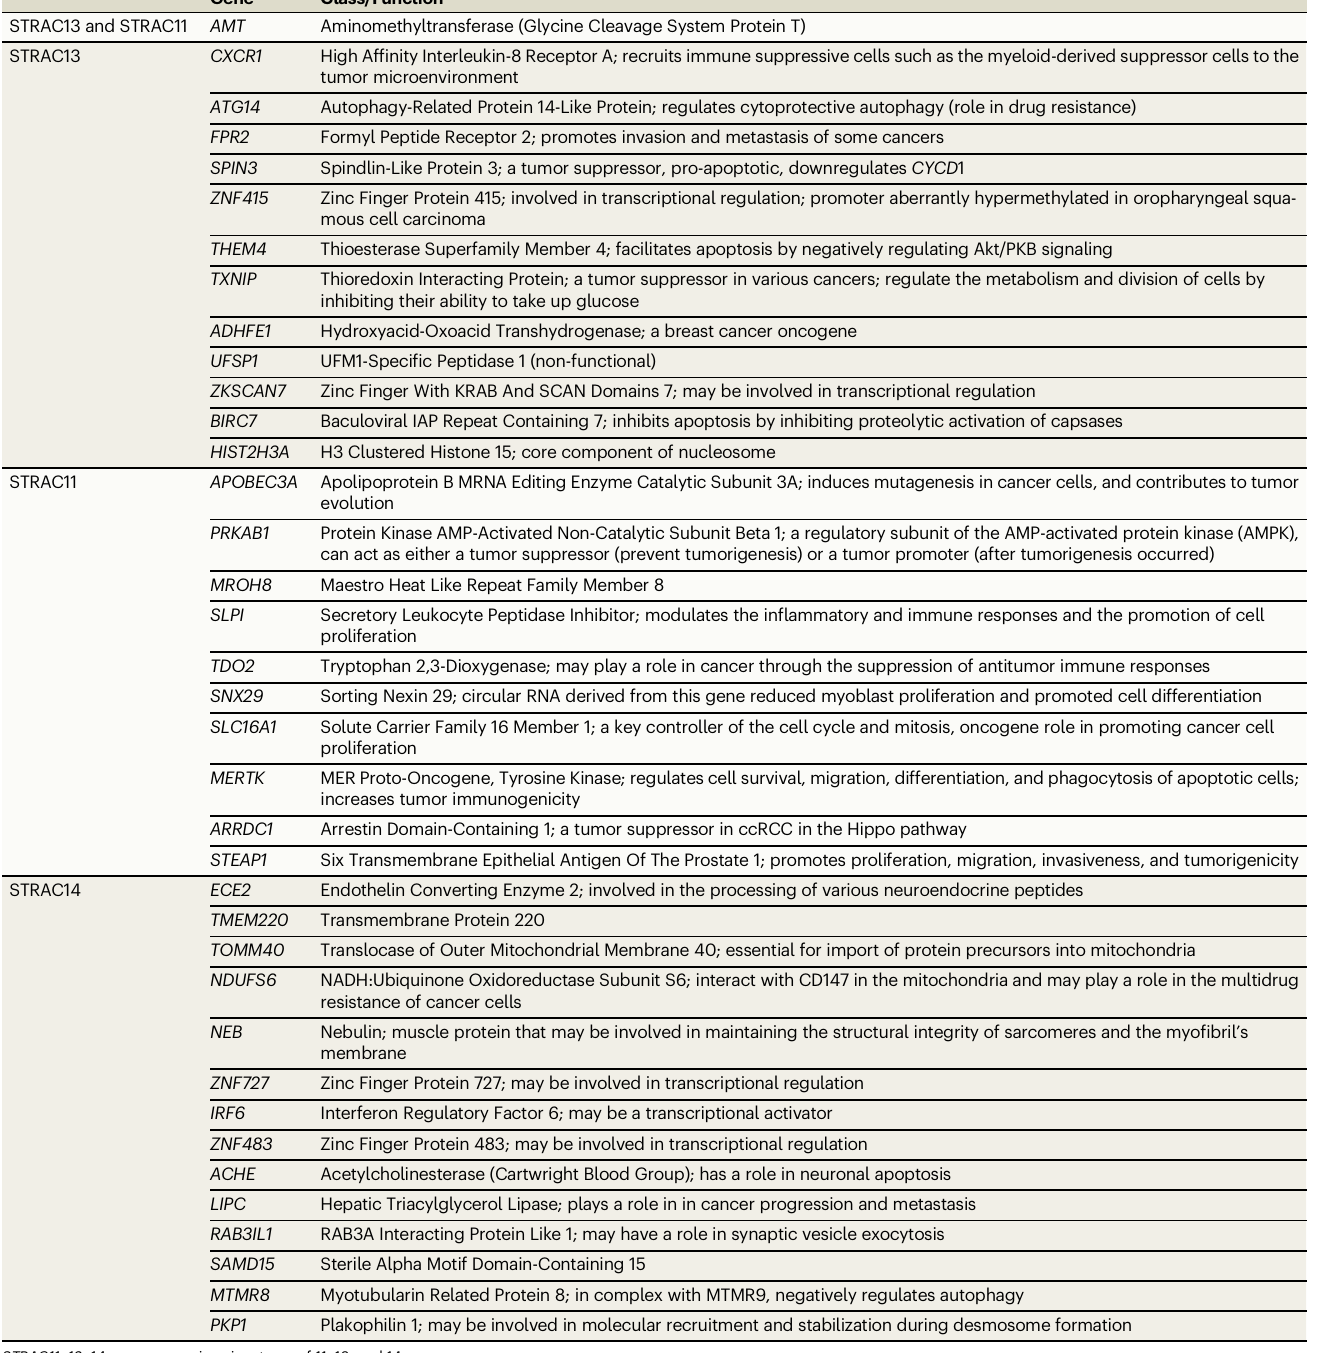
Table 1 | Genes included in STRAC11, STRAC13, and STRAC14 Gene Class/Function STRAC13 and STRAC11